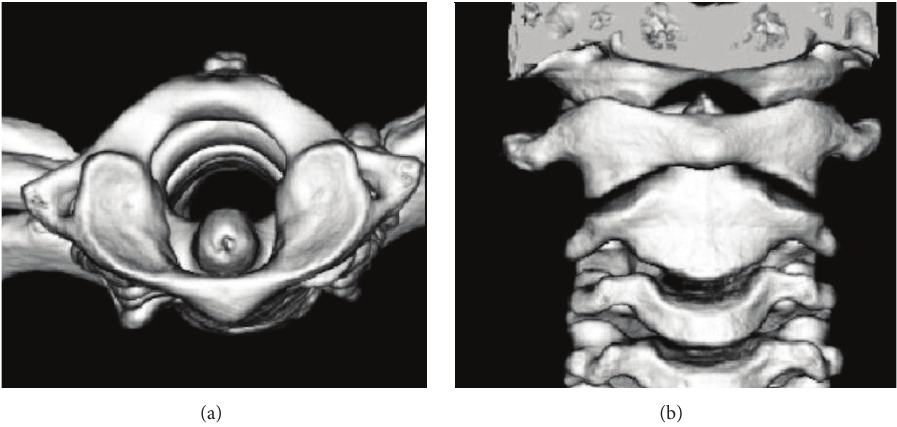
Figure 2: Axial (a) and coronal (b) view of 3DCT after treatment revealed normal appearance in atlantoaxial